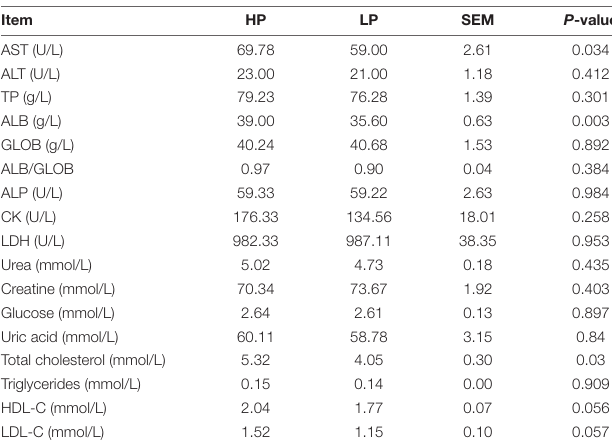
TABLE 4 | Serum biochemical indices of cows in the HP and LP